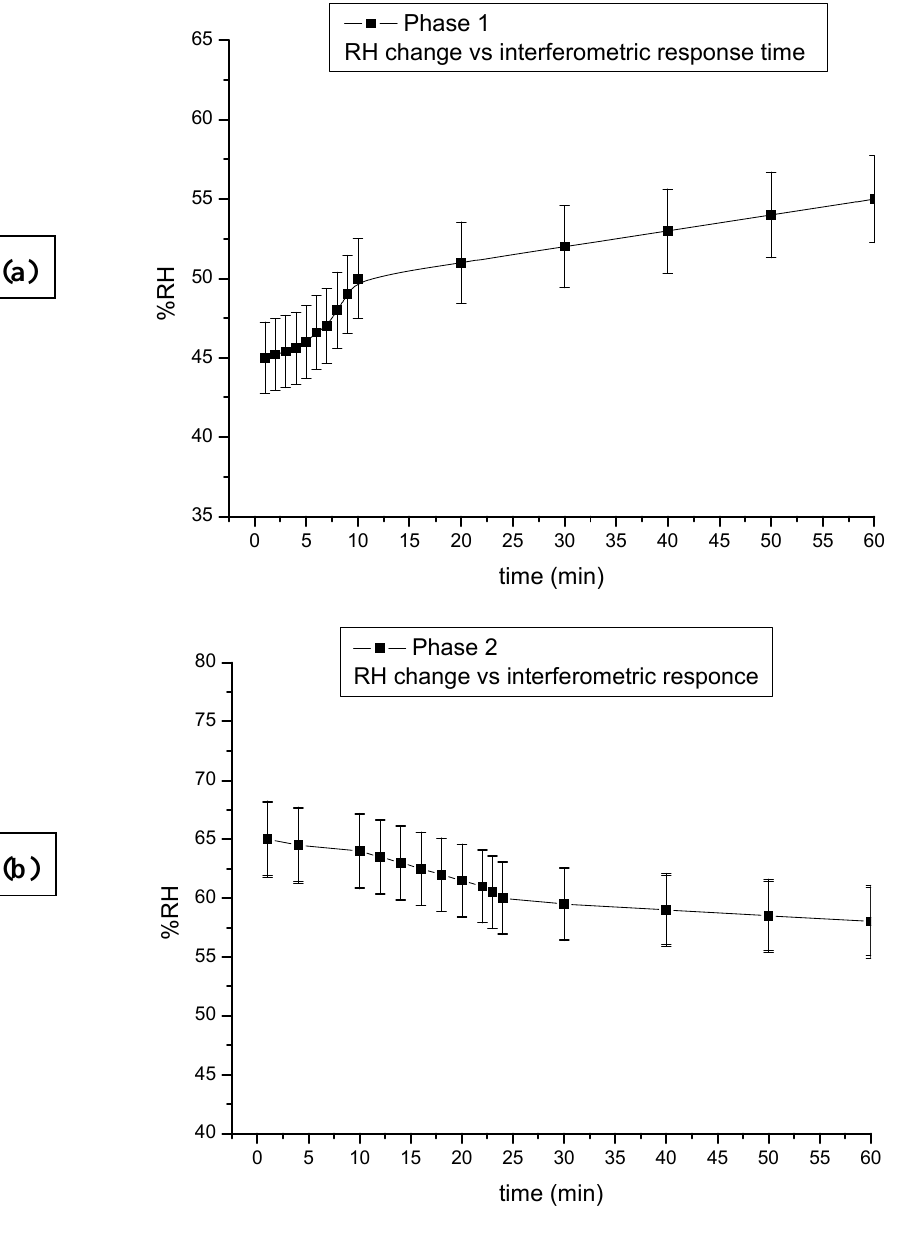
Figure 3. Graphs of the average total displacement response time of samples of wood and ivory during gradual RH% changes, in (a) Phase 1 displacement is smooth and requires CW exposure and longer interval time to capture interferograms and in (b) Phase 2, samples react smoothly with a similar range of CW exposure and interval times to that seen in Phase